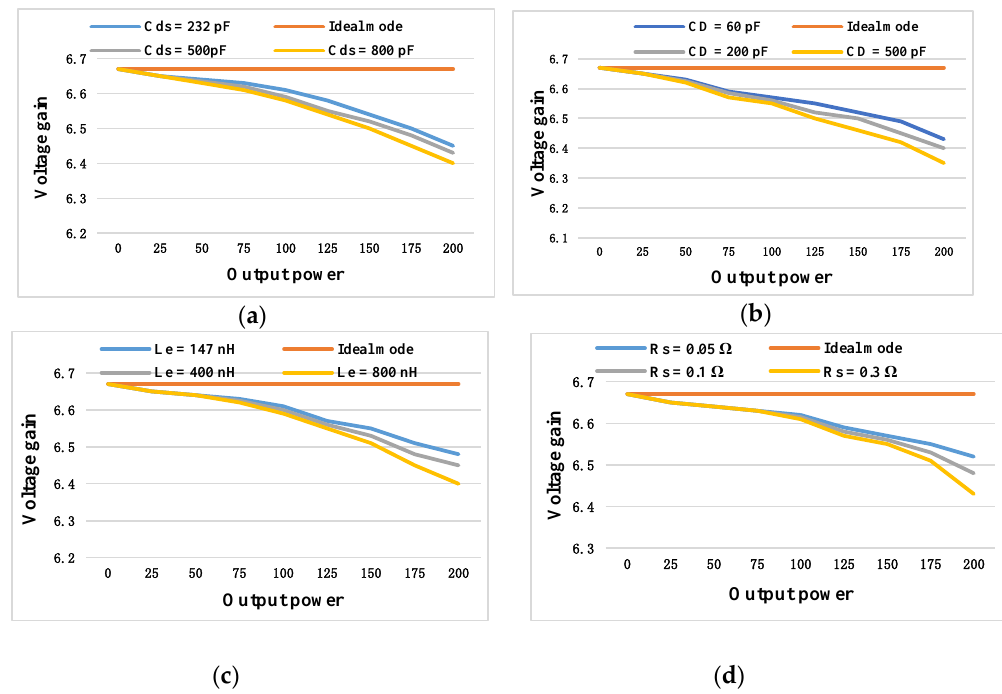
Figure 10. Comparisons of the influence of various parasitic parameters on the output gain. ( a ) Influences of numerical value of C ds . ( b ) Influences of numerical value of C D . ( c ) Influences of numerical value of C ds . ( d ) Influences of numerical value of C ds .